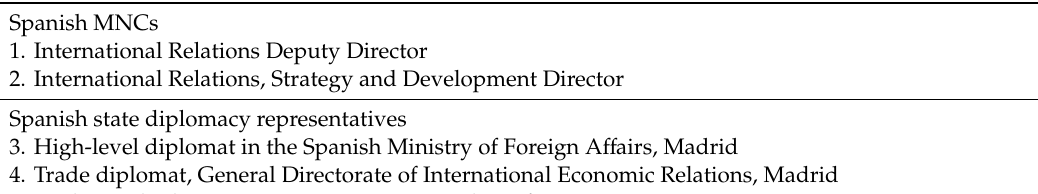
Table 1. Focus Group 2.